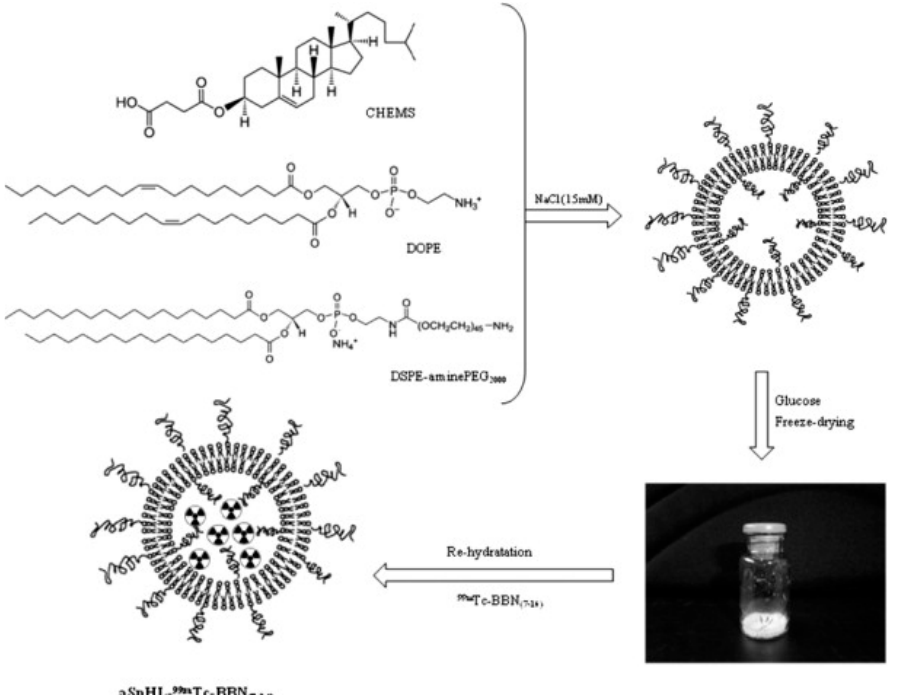
Figure 8. Technetium-99m labeled BBN(7–14) ligand can be incorporated in the liposome by encapsulating it inside the vesicle. CHEMS—cholesteryl hemisuccinate; DOPE—dioleoylphosphatidylethanolamine. Reprinted with permission from ref. [75]. Copyright 2022, Elsevier.